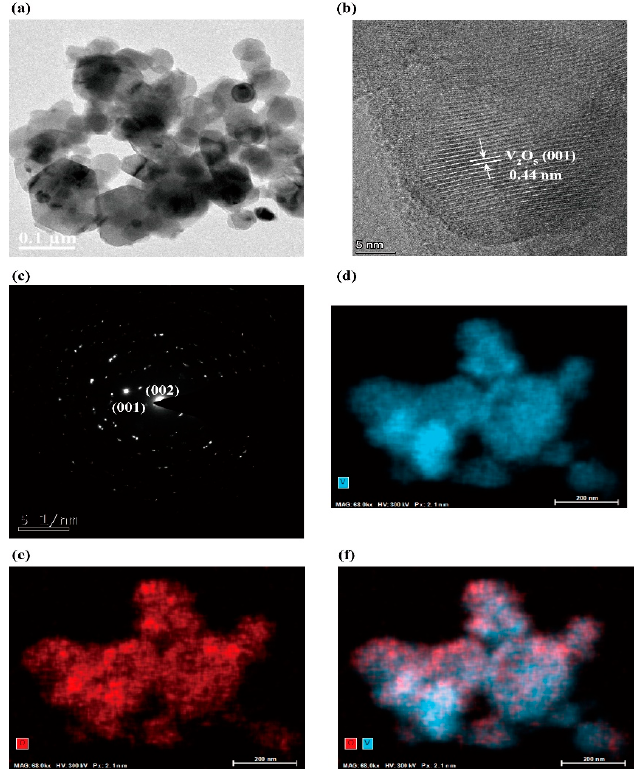
Figure 2. ( a ) TEM image, ( b ) HRTEM image, ( c ) SAED and EDAX color mapping of ( d – f ) of V 2 O 5